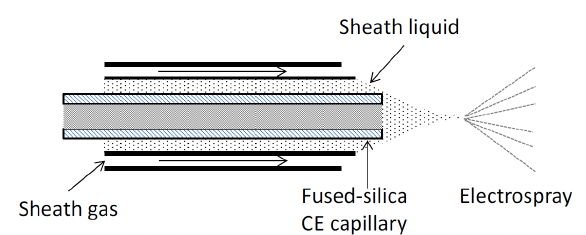
Figure 2 Schematic of the coaxial sheath-liquid interface To overcome the sample dilution problem in the